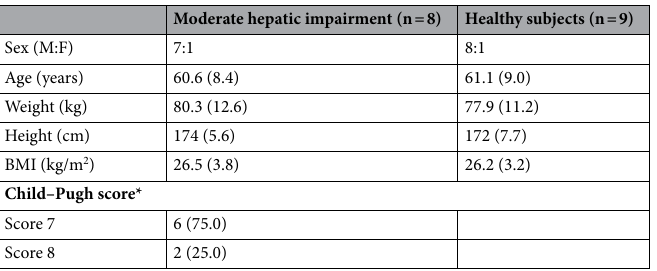
Table 1. Demographic characteristics. Data are expressed as arithmetic mean (SD), as a ratio for sex, or as n for Child–Pugh score (%). BMI body mass index, F female, M male, n number of subjects, SD standard deviation. *Calculated at screening.